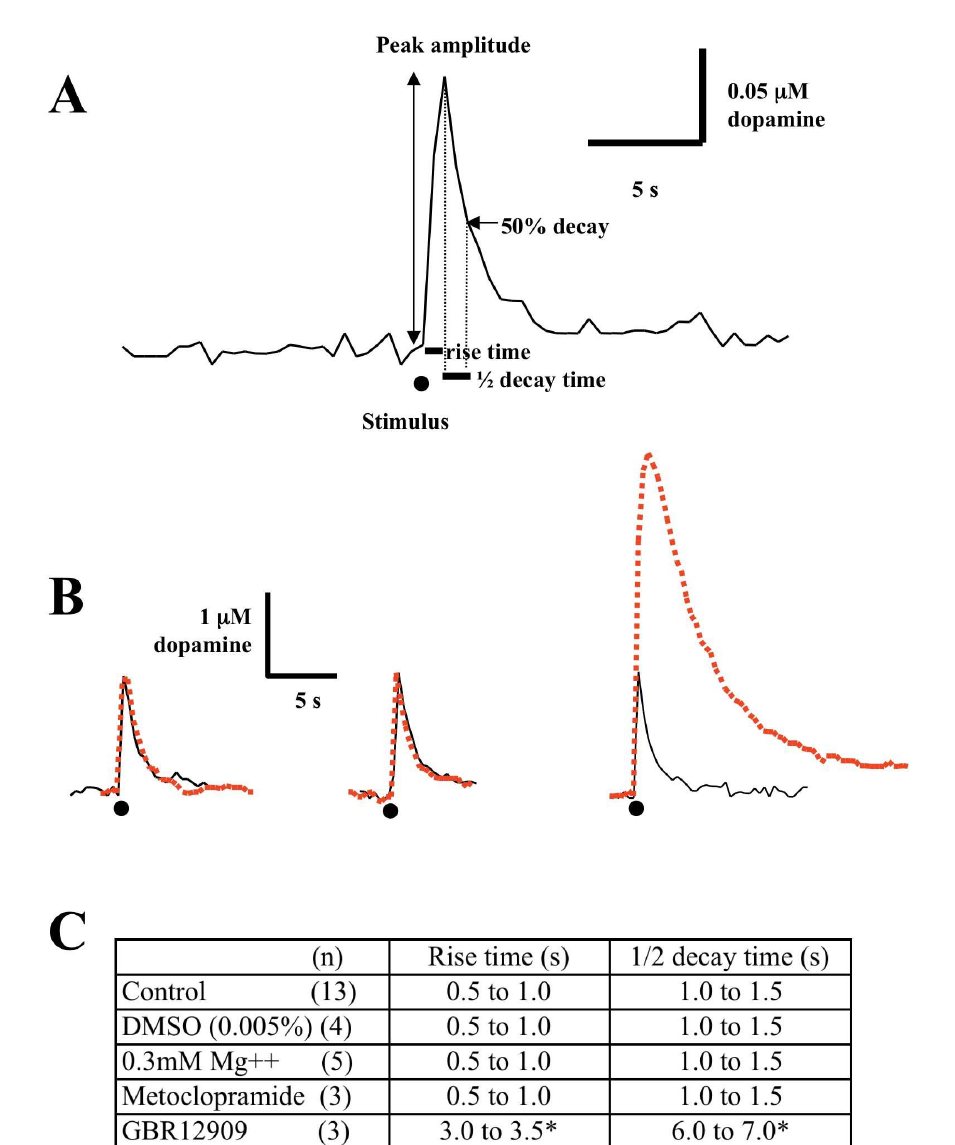
Figure 4. Effect of low Mg 2+ , metoclopramide and GBR12909 on single pulse evoked dopamine